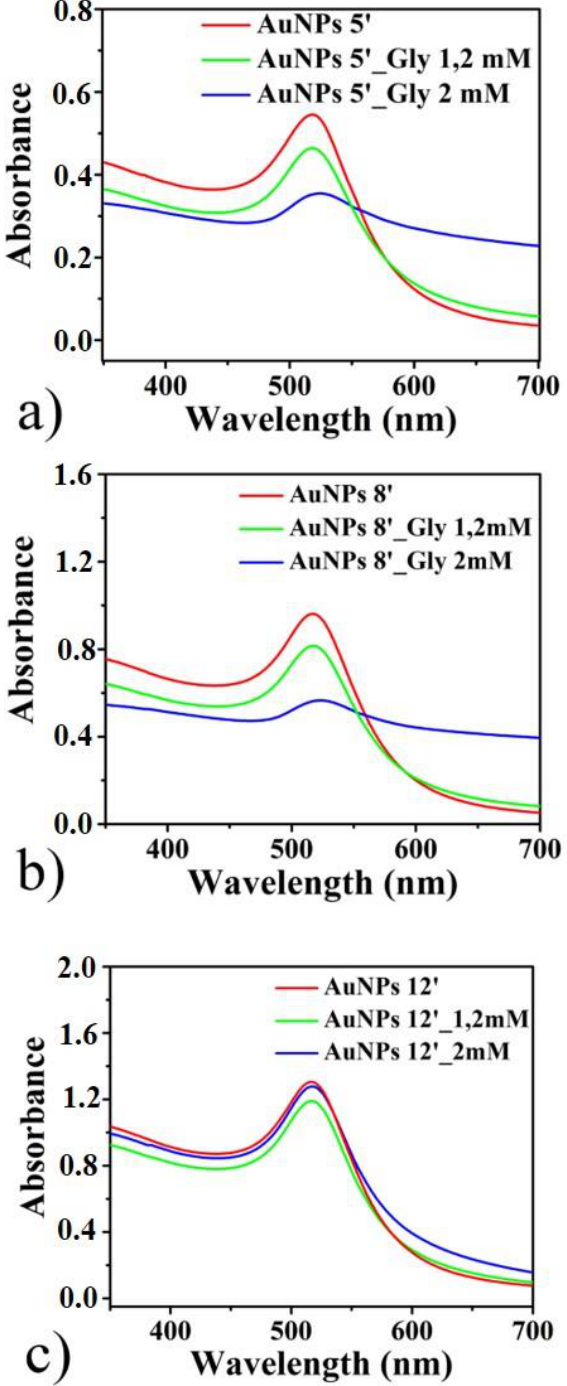
Figure 6. UV-Vis (Ultraviolet-Visible) absorbance spectra of 5′ AuNPs ( a ), 8′ AuNPs ( b ) and 12′ Au NPs( c ) colloidal solution with different concentration of glyphosate.